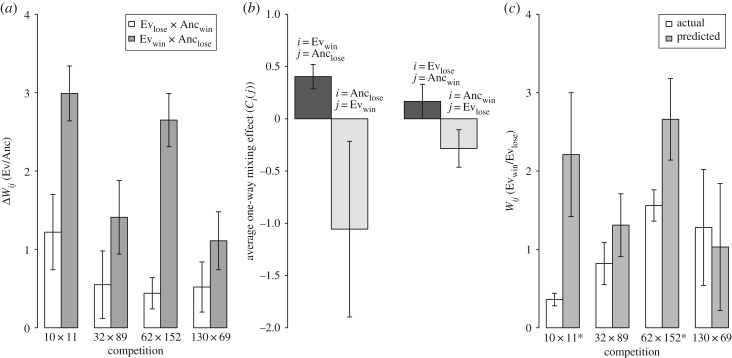
Evolution during vegetative growth and swarming increased competitiveness against ancestors during starvation-induced development, but to a greater extent among winners of evolved-versus-evolved competitions. (a) Each ΔWij value represents the change in developmental competitiveness of the focal evolved strain relative to its reciprocal ancestor due to experimental evolution. The (small and non-significant) Wij value between the two ancestors (GJV1 versus GJV2) has been subtracted from the value obtained from the evolved-ancestor competition to yield the evolutionary change in developmental competitiveness (‘Evwin’ and ‘Evlose’ refer to the winner and loser of an evolved–evolved competition and ‘Ancwin’ and ‘Anclose’ refer to the proximate ancestors of those evolved competitors, respectively). (b) Average one-way mixing effect Ci(j) estimates for Evwin and Anclose competitors in Evwin–Anclose pairings and for Evlose and Ancwin competitors in Evlose–Ancwin pairings. In all cases, the Ci(j) value pertains to the strain category i when mixed with the strain category j. (c) Predicted and actual Wij values for the winning competitor of each evolved–evolved pair for mixed competitions during development. Predicted values are based on the values of evolved-ancestor competitions. Strains 11, 89, 152 and 69 were the winning competitors for these four pairs. Asterisks indicate significant differences between predicted and actual outcomes. Error bars represent 95% confidence intervals.